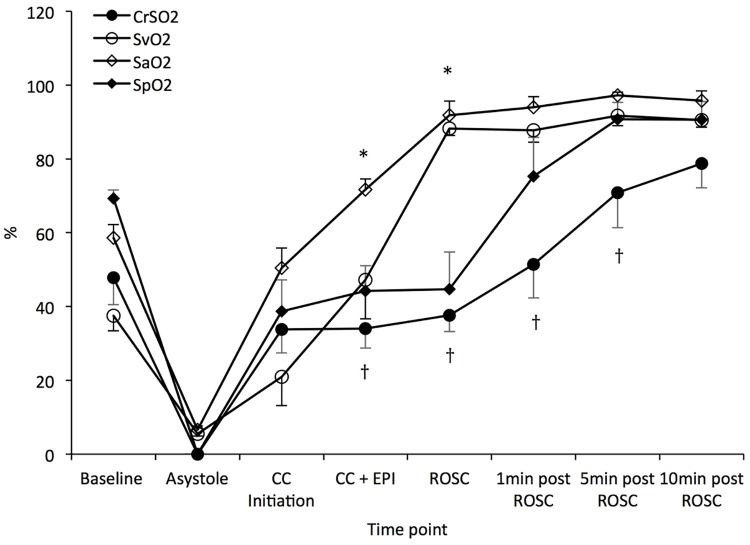
Cerebral rSO2, preductal SpO2, SaO2 and SvO2 during study period in lambs with ROSC.Pulse oximetry and NIRS are not reliable during resuscitation as shown by a discrepancy between SaO2 and SpO2, and SvO2 and cerebral rSO2 during chest compressions as well as in the first few minutes into ROSC. Data are mean ± SEM bars. * P <0.05 SvO2 vs. SpO2; † P <0.05 SvO2 vs. cerebral rSO2.